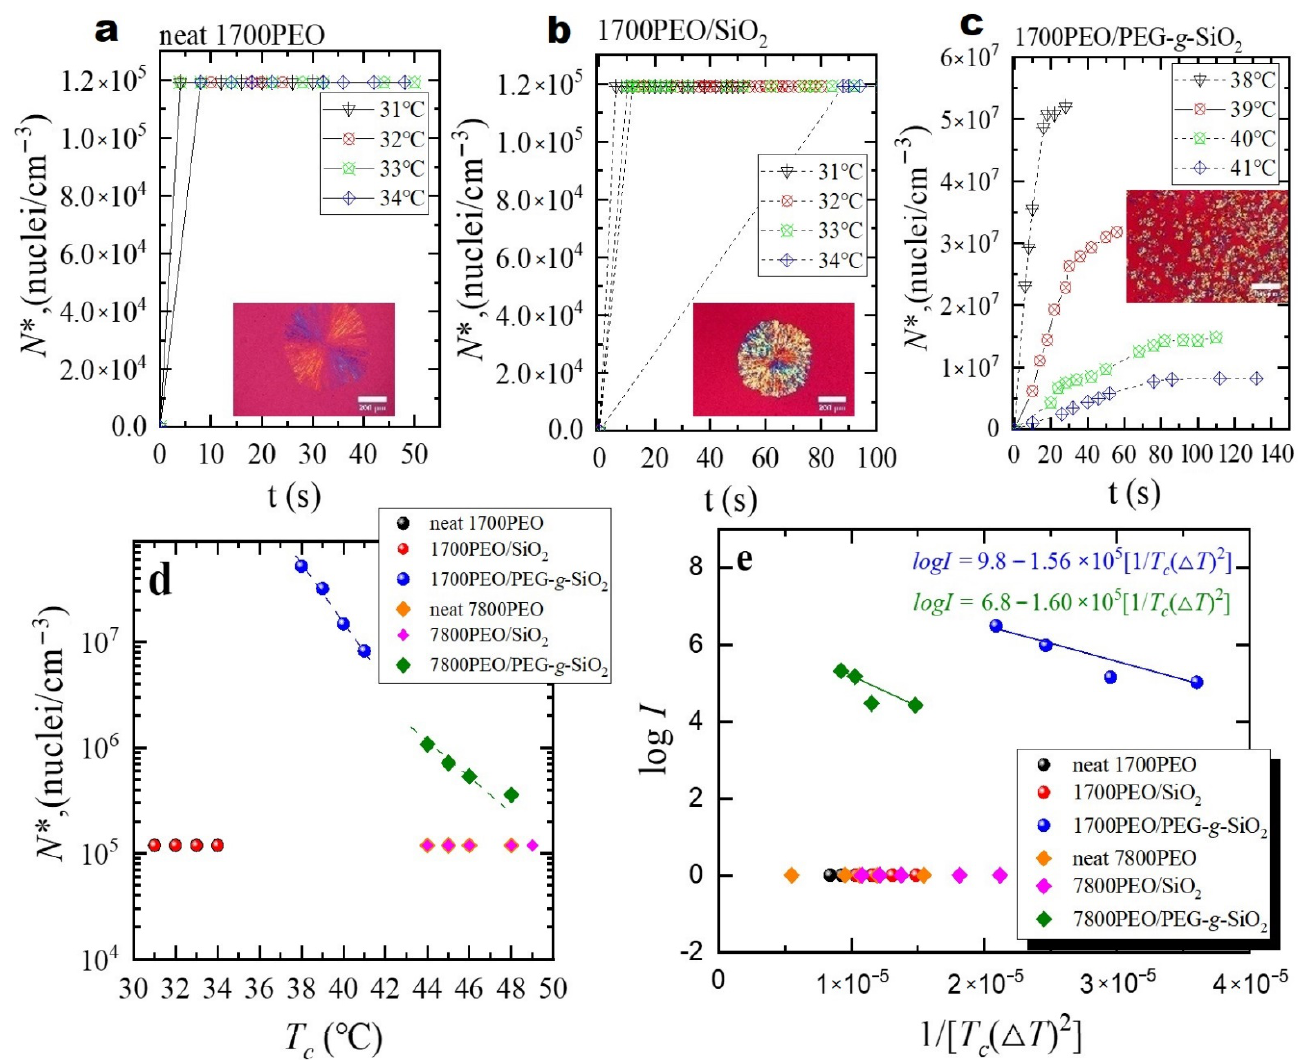
Figure 2. Nucleation density as a function of time at each crystallization temperature ( a ) neat PEO ( b ) PEO/SiO 2 , ( c ) PEO/PEG- g -SiO 2 . The inset images represent the PLOM images of PEO nanocomposites corresponding to 34 ◦ C for neat PEO, 32 ◦ C for PEO/SiO 2 and 39 ◦ C for PEO/PEG- g -SiO 2 . The matrix molecular weight of PEO is 1700 g/mol. ( d ) Nucleation densities of neat PEO, PEO/SiO 2 , and PEO/PEG- g -SiO 2 at different T c . ( e ) Plots of log I versus 1/[ T c ( ∆ T ) 2 ], the solid line is the fitting according to Equation (1).